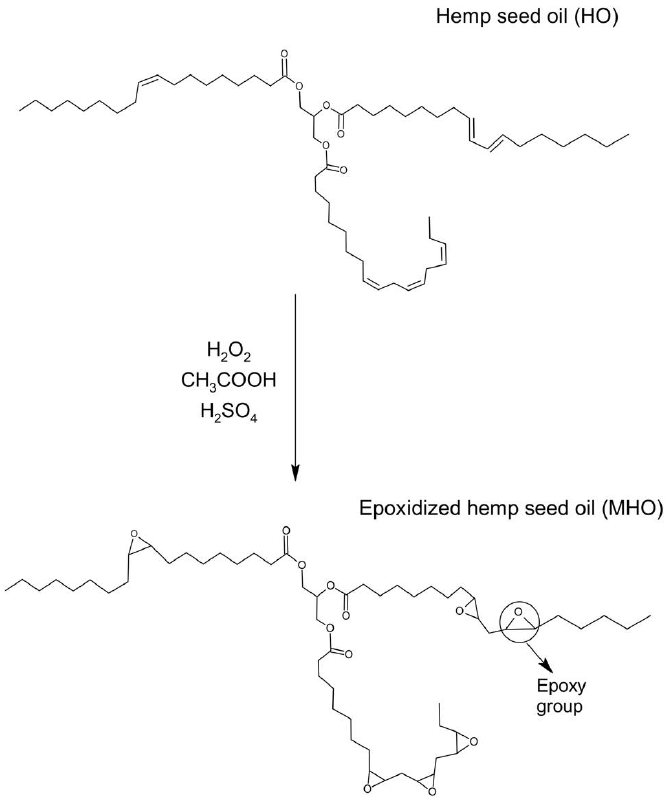
Figure 2. Schematic representation of the epoxidation reaction.